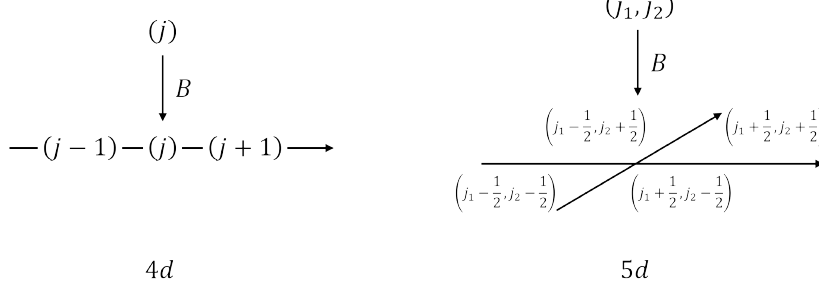
) , which form a 2- , j 1 2